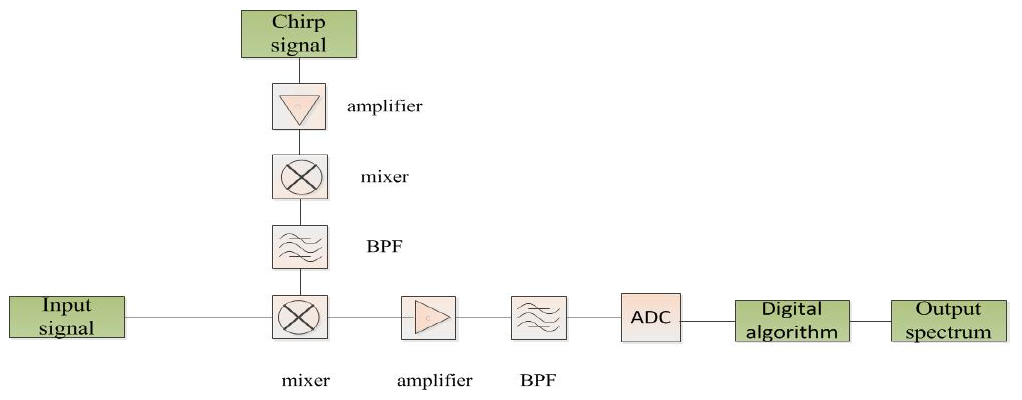
Figure 2. Simplified structure of the CTS system with the LPSA algorithm for fast pulse compression.